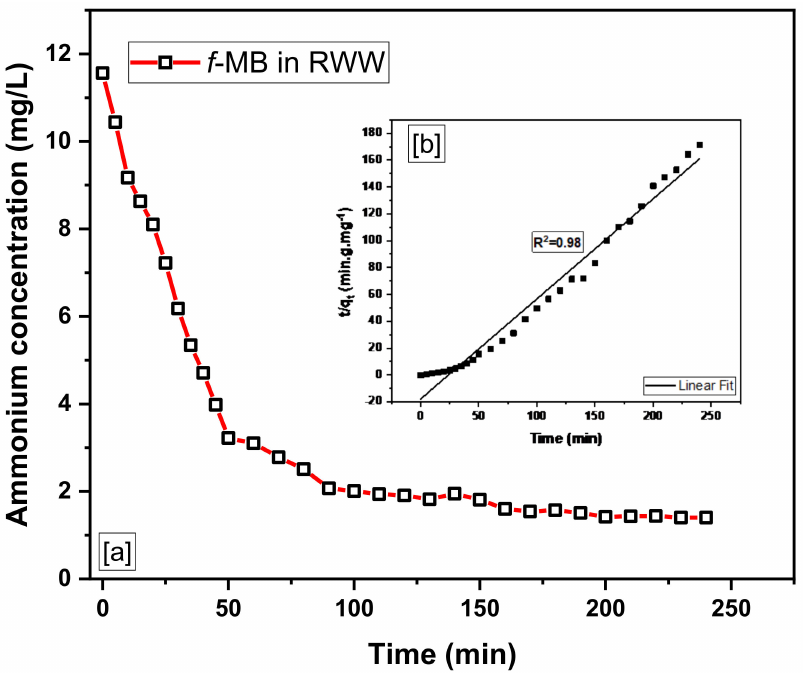
Figure 6. ( a ) Ammonium removal efficiency of f -MB in real wastewater. ( b ) Pseudo-second-order kinetics of ammonium-uptake by f